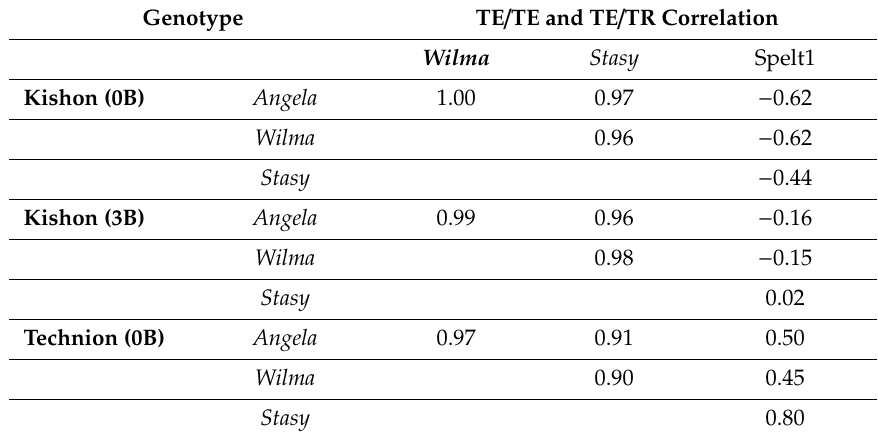
Table 3. Correlation between Angela , Wilma , Stasy , and Spelt1 relative copy numbers in spike somatic and meiotic tissues of Ae. speltoides individual